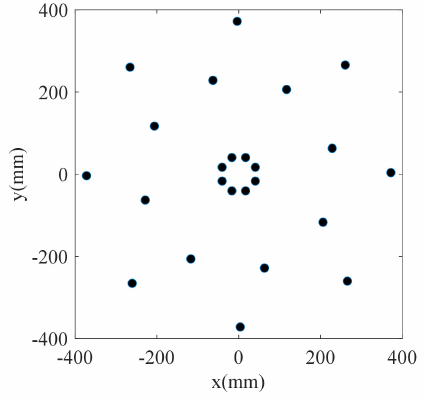
Figure 4. The 24channel microphone